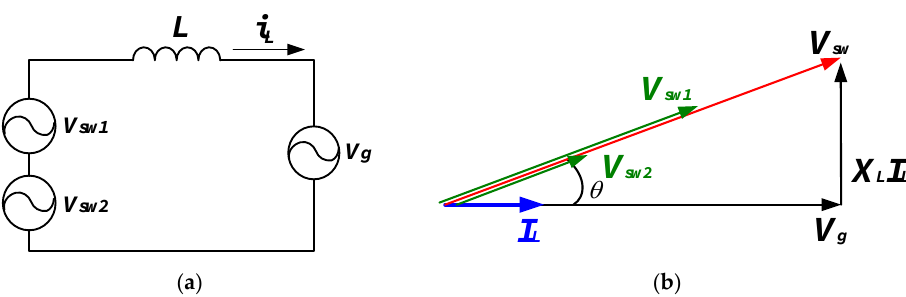
Figure 6. AC-side equivalent circuit and the phasor diagram of H-bridge output voltages for the unity power factor. In figure, XL is the impedance of the output inductor, X L = ωL. ( a ) AC-side equivalent circuit, ( b ) phasor diagram of voltages and current for the unity power factor.